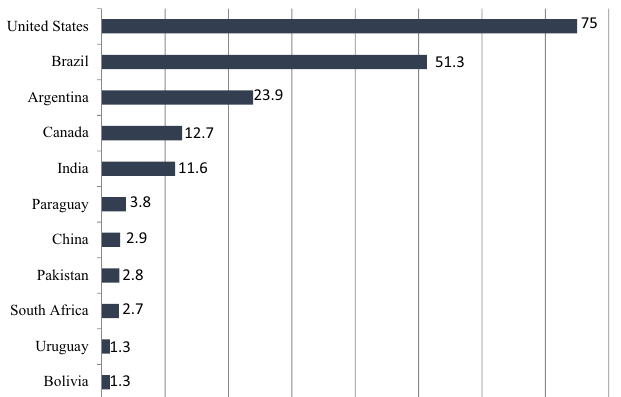
Figure 2. Area of genetically modified (GM) crops worldwide in 2018, by country (in million hectares) 33 .